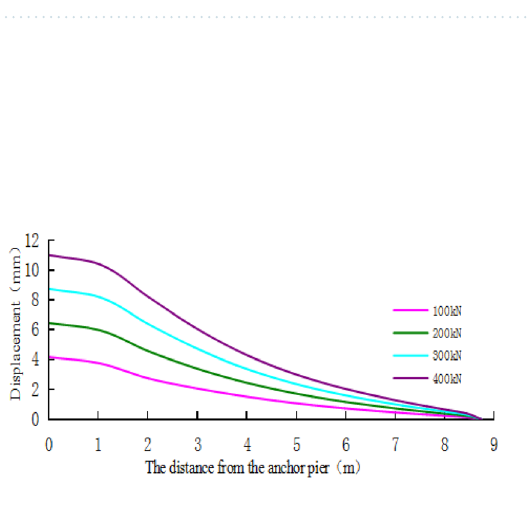
Figure 29. The horizontal displacement of soil along cable